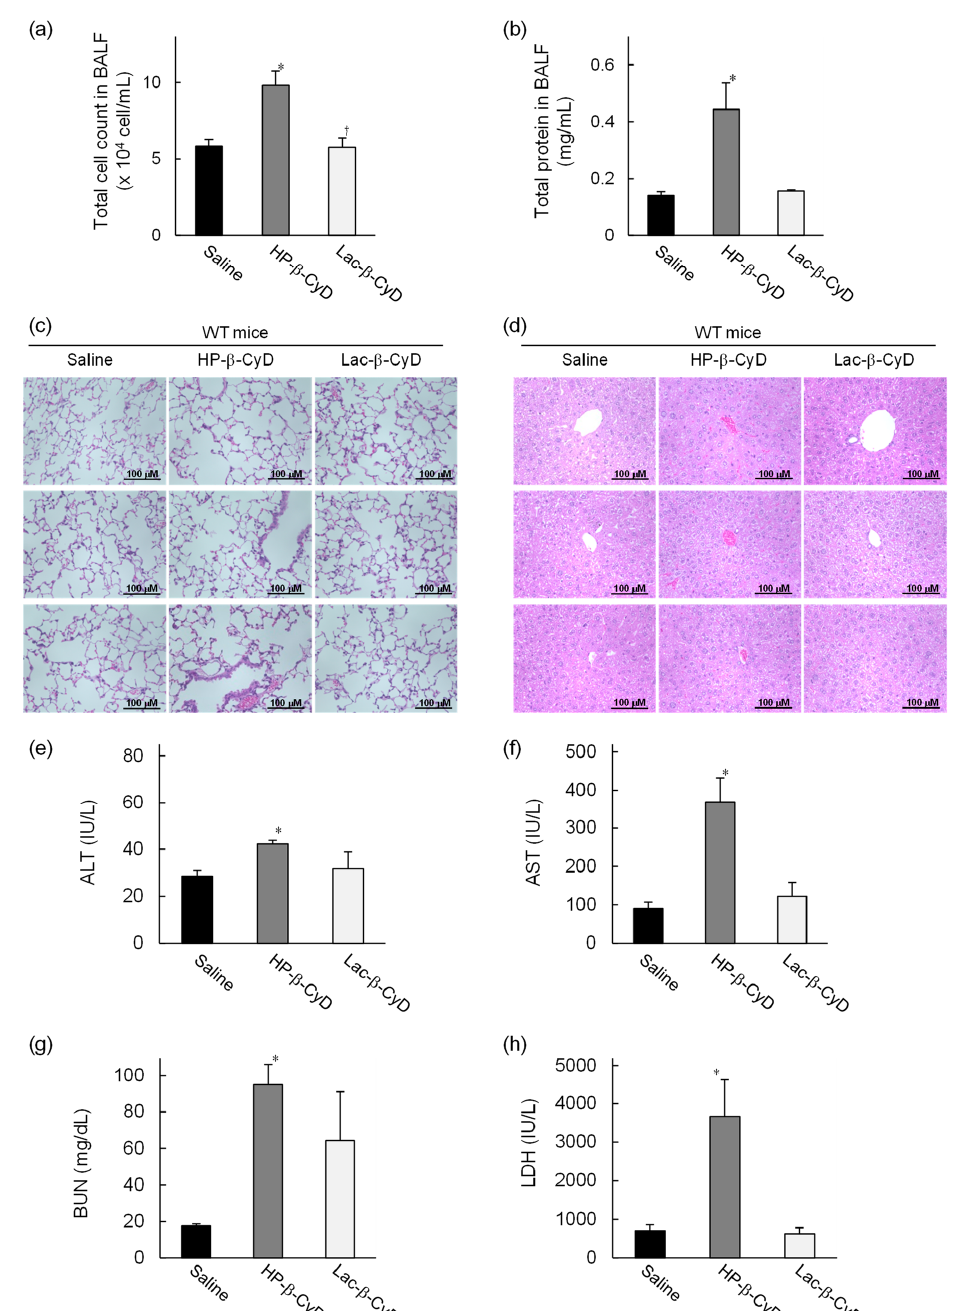
Figure 4. In vivo safety evaluation of Lac- β -CyD after high dose administration to WT mice. Lac- β -CyD (8 mmol / kg, 23,632 mg / kg) or HP- β -CyD (8 mmol / kg, 11,120 mg / kg) was administered to eight-week-old WT mice via a single subcutaneous injection. Blood and organs were collected 8 h after the injection. Lung toxicity was evaluated by ( a ) total cell count in BALF, ( b ) total protein concentration in BALF, and ( c ) histological analysis of the lungs. Liver toxicity was evaluated by ( d ) histological analysis of the liver, and ( e ) AST and ( f ) ALT levels in the plasma. Renal injury and acute toxicity were evaluated by BUN ( g ) and LDH ( h ) levels in plasma, respectively. These figures show the representative images of three di ff erent mice ( c , d ). Each value represents the mean ± S.E.M. of 4-8 experiments. * p < 0.05, compared to control (saline-treated) WT